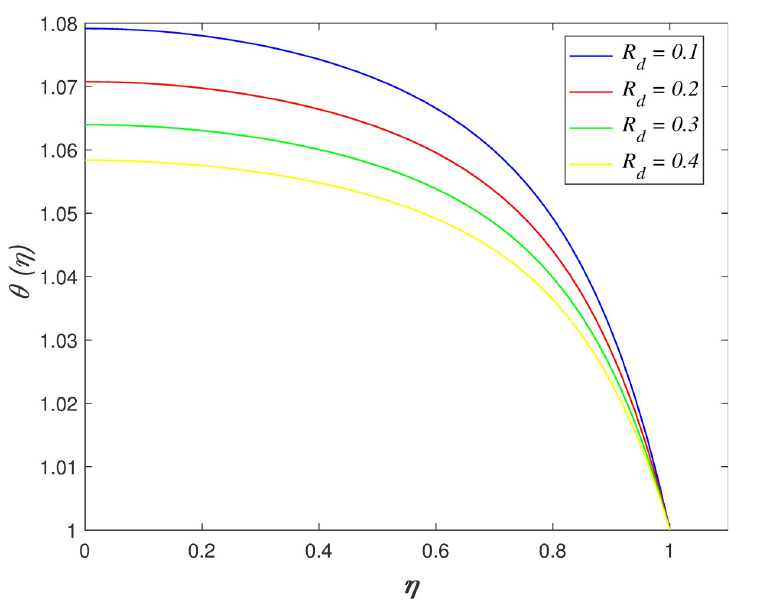
Fig 18. Impact of R